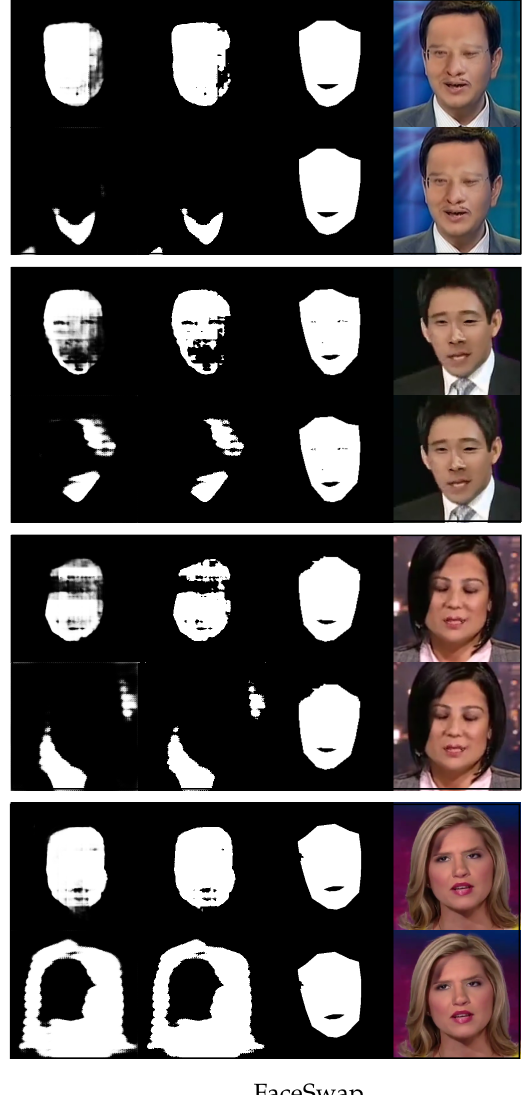
Figure 6. Four rows of randomly selected images from FaceSwap and their predicted results for the fake region with one-shot fine-tuning. The top sub-row of each row is the result generated by the proposed method, and the bottom sub-row of each row is the result without using the proposed method. In each sub-row, from right to left, there is the image altered by FaceSwap , the ground truth of the altered region (mask), the binary predicted output, and the gray-scale predicted